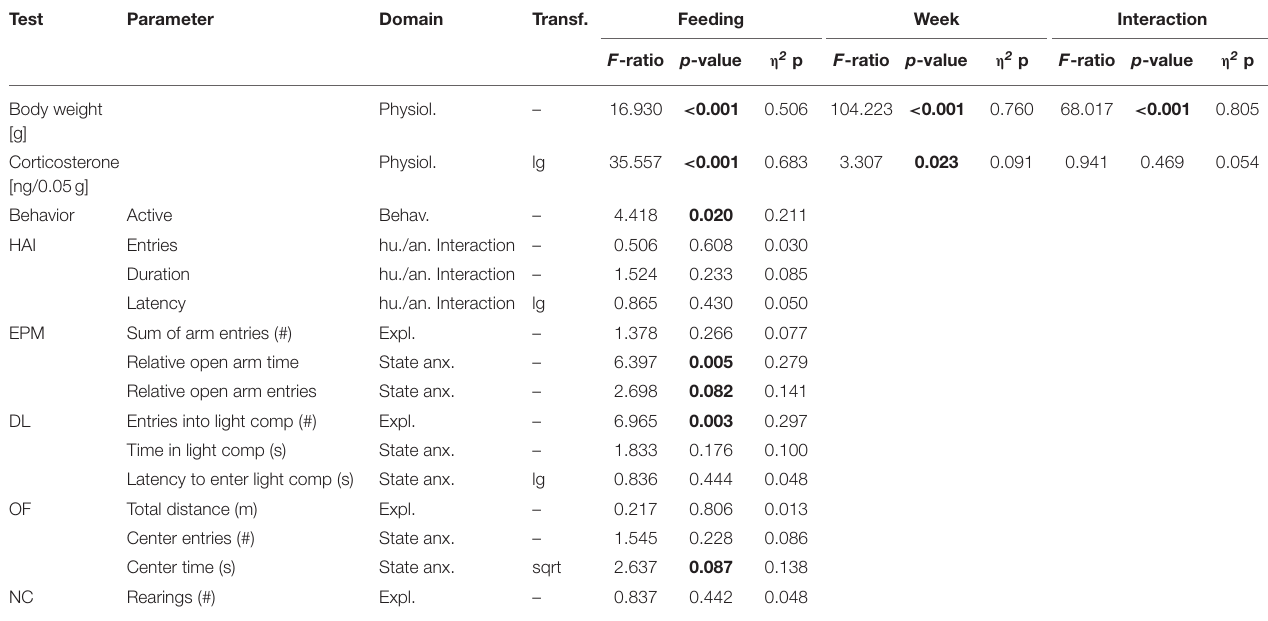
TABLE 2 | Statistics experiment 1: Presented are interaction and main effects of “time” and “feeding routine” ( F -ratios, p -values, and estimated effect sizes) on weight, fecal corticosterone metabolite (FCM) concentrations, activity in the home cage and on individual common parameters that were assessed in the